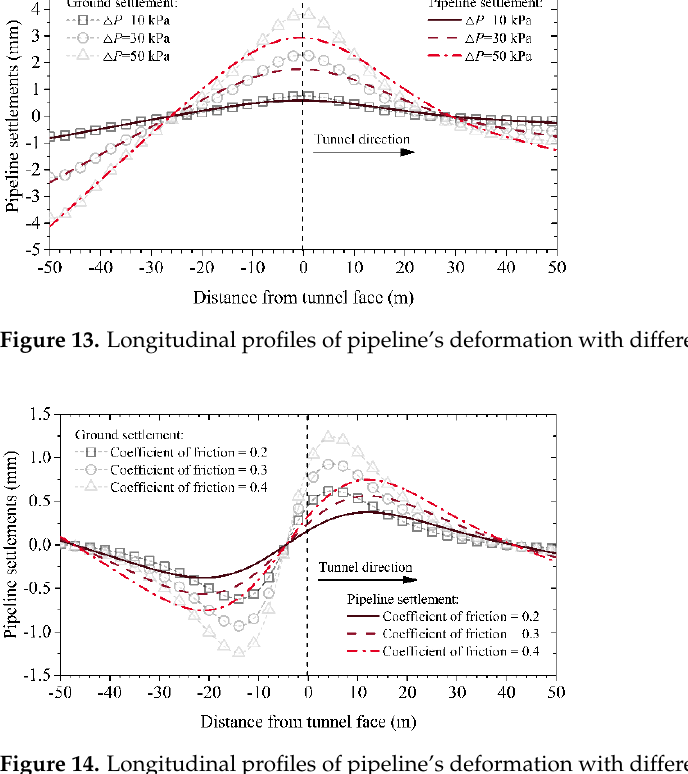
Figure 13. Longitudinal profiles of pipeline’s deformation with different support pressures.